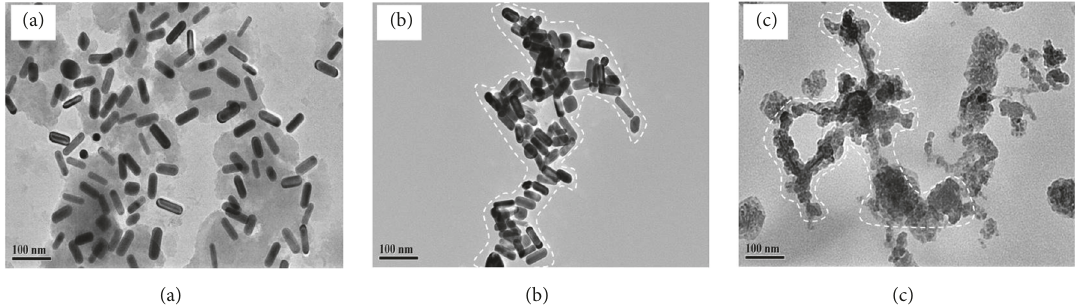
Figure 2: TEM images of (a) AuNRs, (b) Au-HgNRs, and (c) Au-HgNRs in the presence of S 2− .